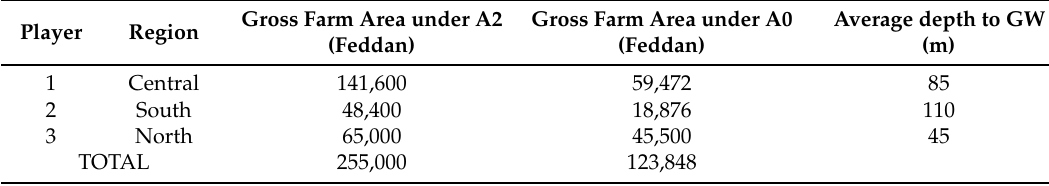
Figure 1. Project area: The areas marked with red lines indicate the Southern sub-region (player 2); the areas marked with purple lines indicate the Northern sub-region (player 3); and the unmarked blocks indicate the Central sub-region (player 1). Table 1. Area and depth to water table by the 3 sub-regions